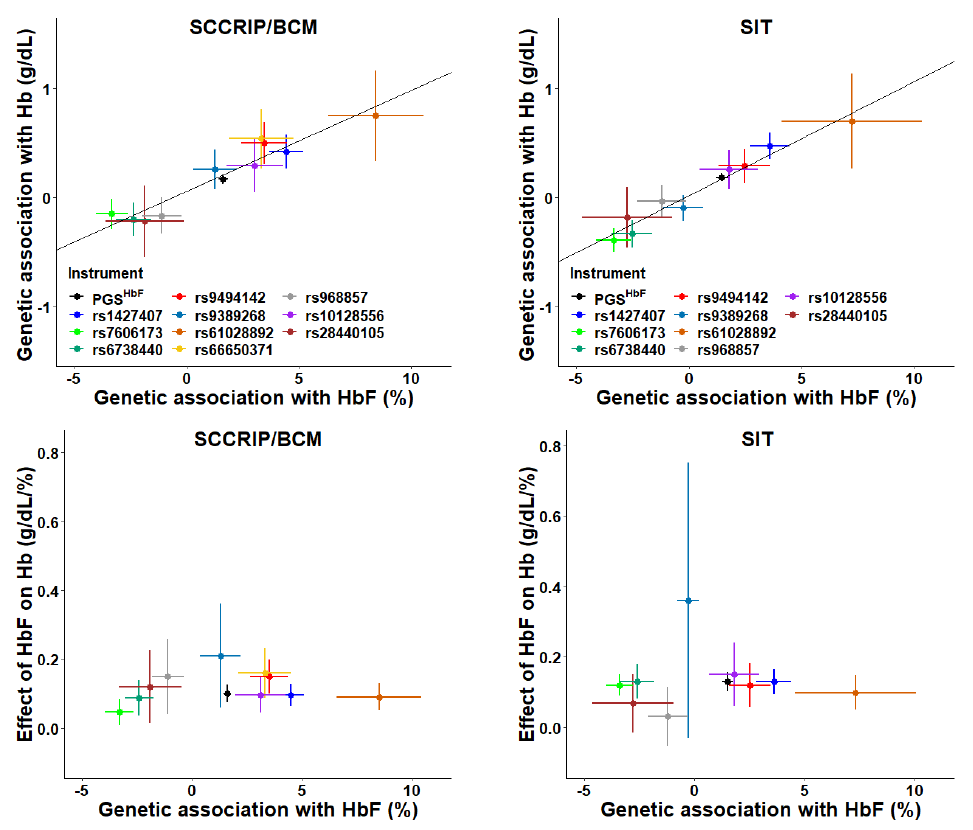
Figure 3. HbF induced by BCL 11 A , HBS 1 L − MYB , and the extended β -globin locus causally influ- ences Hb in SCCRIP/BCM ( left ) and SIT ( right ) patients. ( Top ) panels: X-axis: Genetic association with HbF (%). Y-axis: Genetic association with Hb (g/dL). The genetic associations were done using linear regression models, adjusting for the covariates age, sex, sickle diagnosis (Yes/No), and top 5 PCs. ( Bottom ) panels: X-axis: Genetic association with HbF (%); Y-axis: (Causal) Effect of HbF on Hb (g/dL/%). The Mendelian randomization analysis was done using MREPS. SCCRIP/BMC = Sickle Cell Clinical Research Intervention Program study and Baylor College of Medicine; SIT = Silent Cerebral Infarct Transfusion